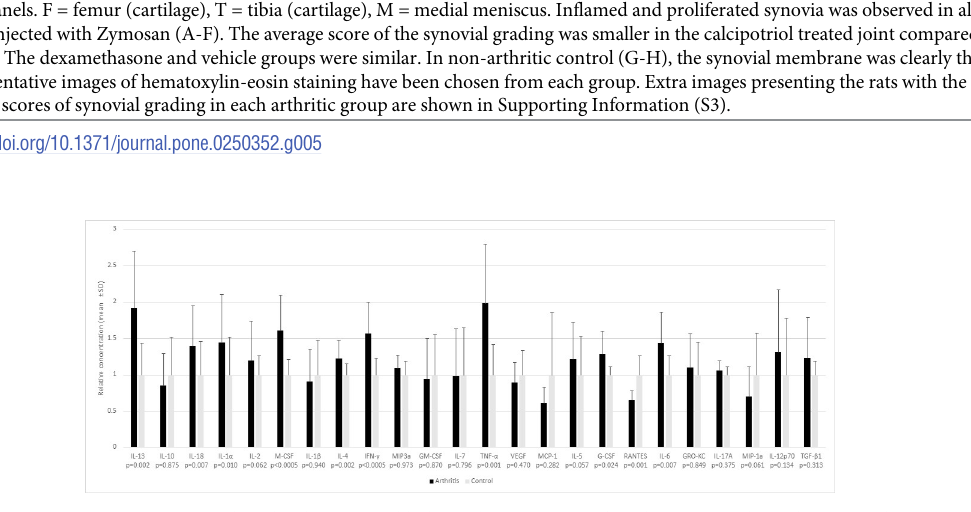
Fig 6. Serum cytokine levels measured before administration of study compounds on day 1 in arthritic rats (n = 25) and before euthanasia in nonarthritic controls. (n = 10). A significant increase in many of pro- and anti- inflammatory cytokines caused by acute arthritis was seen on day 1. RANTES was reduced in the arthritis group vs control (p = 0.002). Bars expressed as mean ± SD.